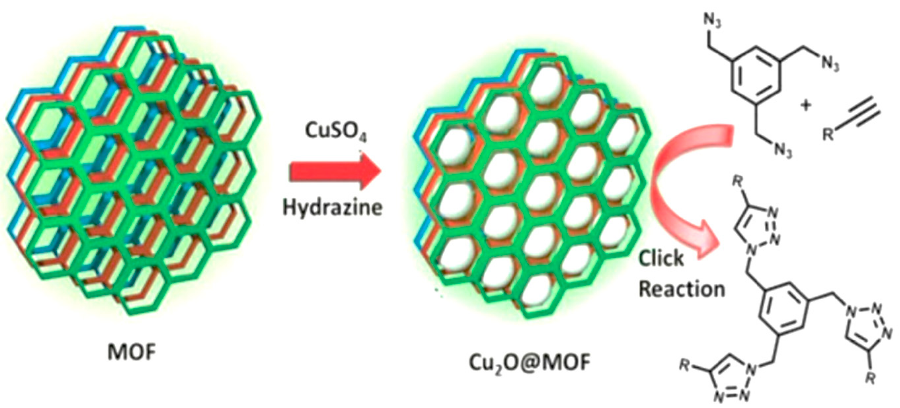
Figure 13. A schematic showing the stabilization of Cu 2 O nanoparticles in 2D layers and the catalytic azide–alkyne cycloaddition reaction. Reproduced from [108] with permission from RSC, copyright: 2015.